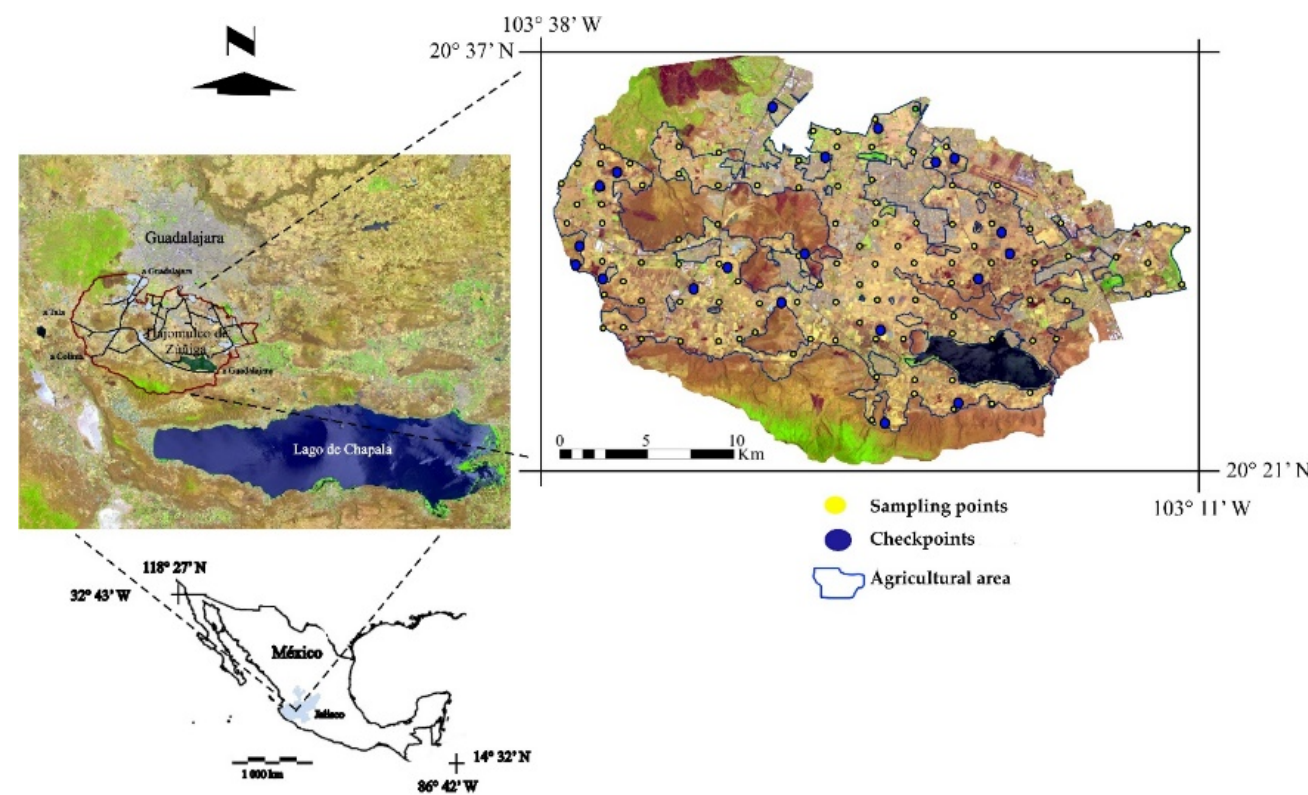
Figure 1. Location of the study area in Jalisco, México.